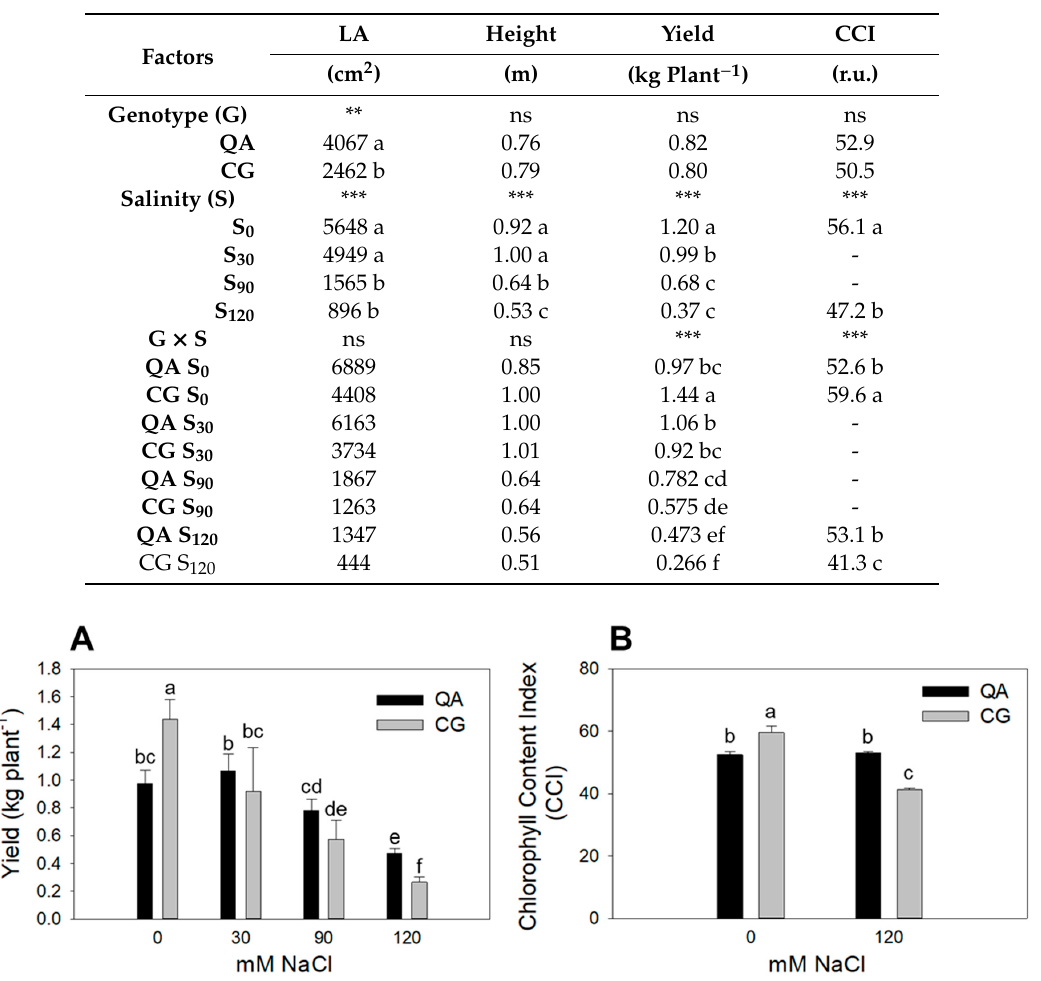
Table 1. Effect of genotype, salinity and their interaction on leaf area, height and yield at 168 days after transplant (DAT) and chlorophyll content index (CCI, DAT 65) of the commercial cultivar (QA) and the landrace (CG) grown at control (0 mM), low salinity (30 mM), moderate salinity (90 mM) and high salinity (120 mM). ns, **, *** indicate not significant or significant differences at p < 0.01 and p < 0.001, respectively, according to ANOVA. In each column, for each factor, means with the same letter are not significantly different according to Duncan’s post hoc analysis ( p < 0.05). LA